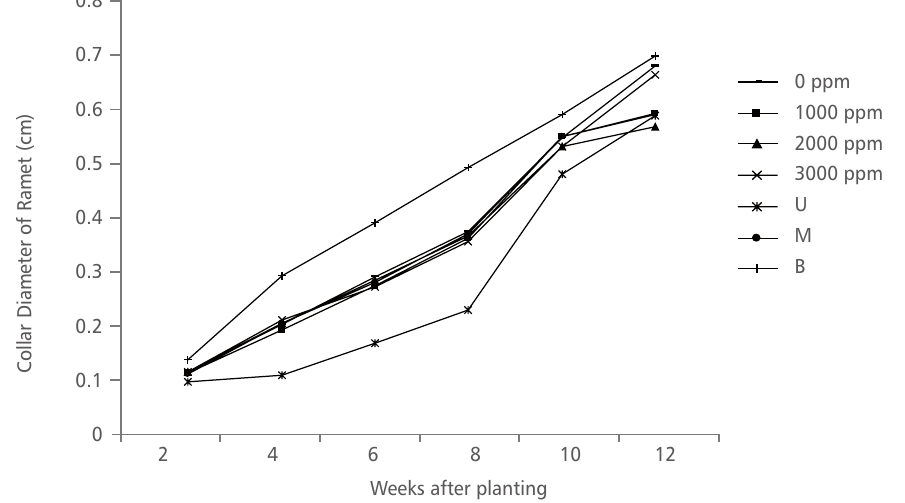
FIGURE 4. D. tripetala ramets collar diameter increament using different IBA hormone concentrations and nodal positions (U= upper node, M = middle node and B = basal